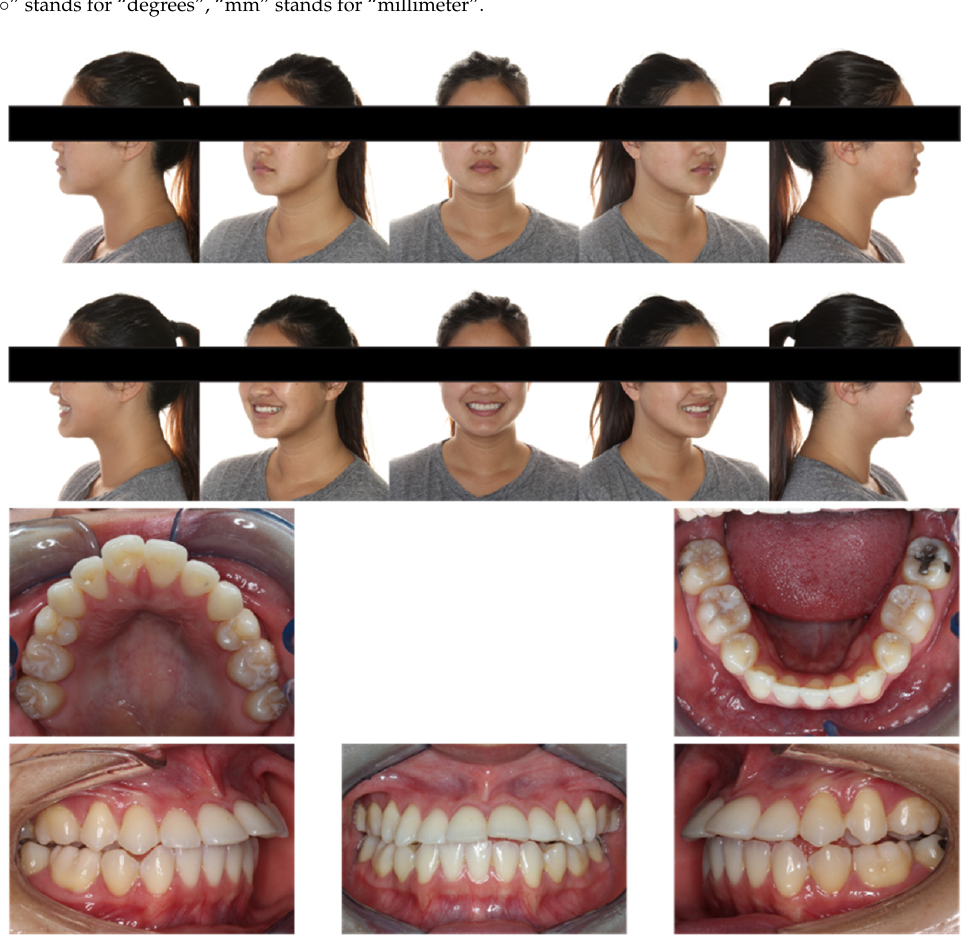
Figure 1. Pretreatment facial and intraoral photographs.